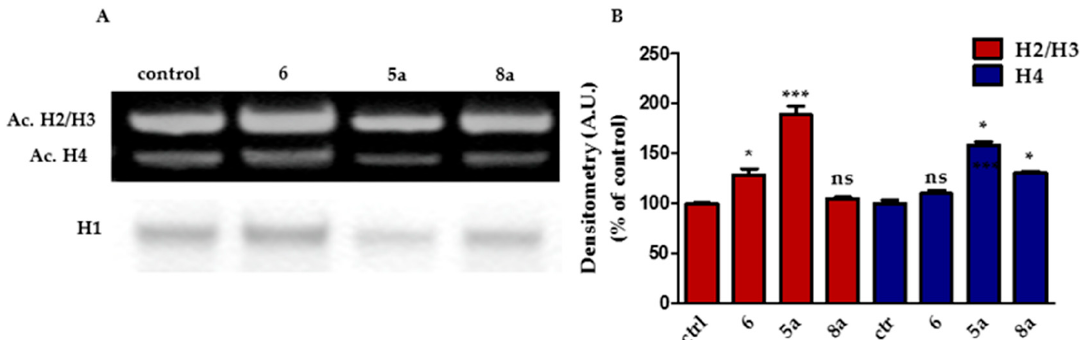
Figure 4. Effect of compounds 5a , 6 , and 8a on histone acetylation levels. ( A ) Cell nuclear extracts were prepared and subjected to Western blot analysis for acetylated (Ac) histones H2/H3 and H4. Histone H1 was used as loading control. A representative experiment is shown, which was repeated three times. ( B ) Densitometric analysis of the bands (mean ± SD; n = 3) is shown. * p ≤ 0.05, *** p ≤ 0.01 vs. control.